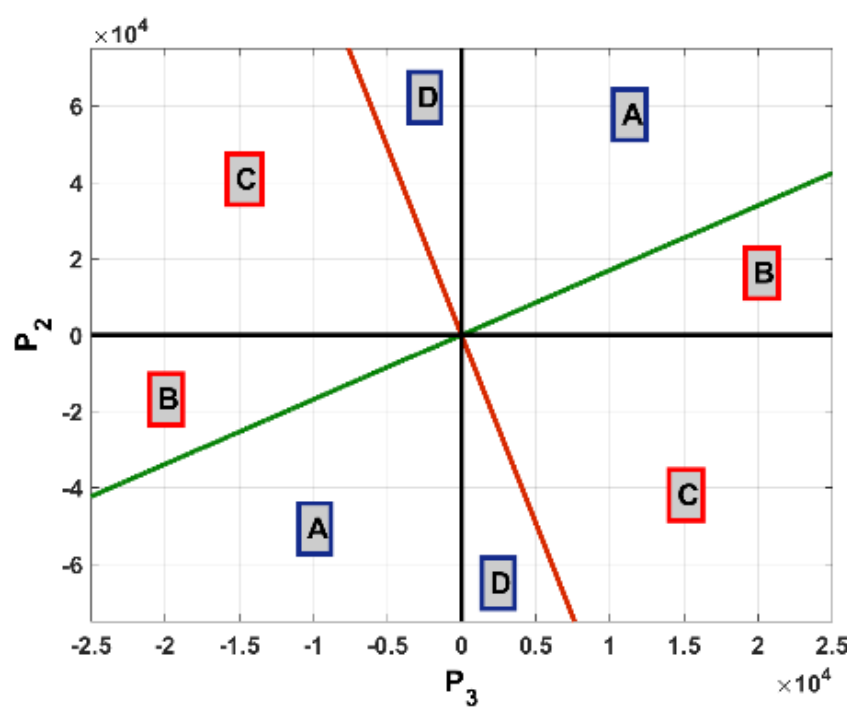
Figure 17. Active power operating zones and limits on Port 2 and on Port 3.